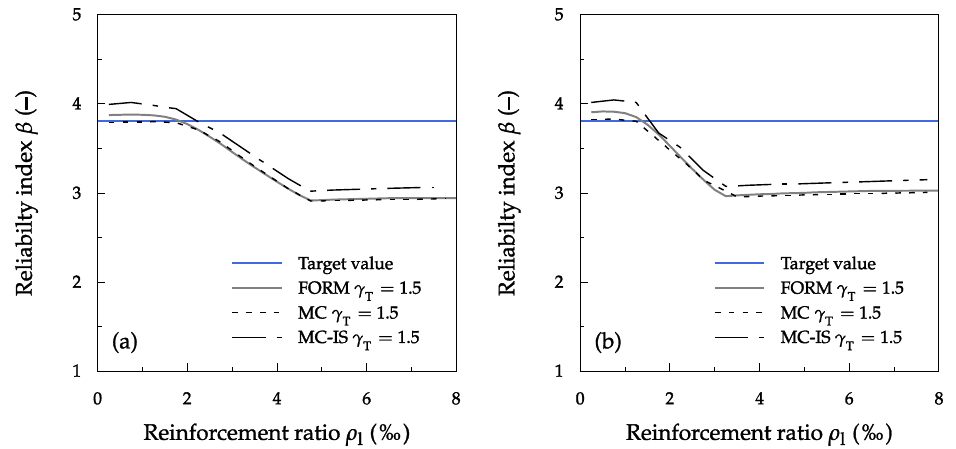
Figure 8. Reliability indices calculated according to FORM, Monte Carlo method (MC) and Monte Carlo method with importance sampling (MC-IS) considering an effective depth of d = 15 mm: ( a ) AR-glass; ( b ) carbon.